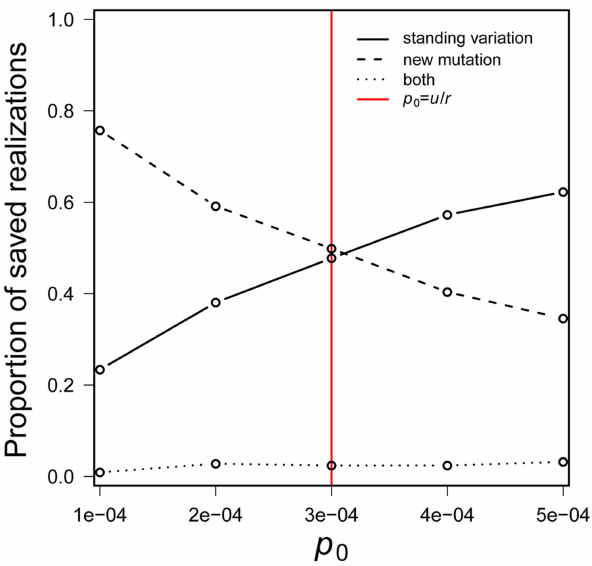
Figure 2. The probability that a population is saved by new mutation versus standing genetic variation. The standing genetic variation plays a greater role in rescue when p 0 . u/r . Simulations assume N 0 =10,000, r =0.00333, s =0.01 and u =10 2 6 with 100, 000 realizations. Red line indicates p 0 = u/r .